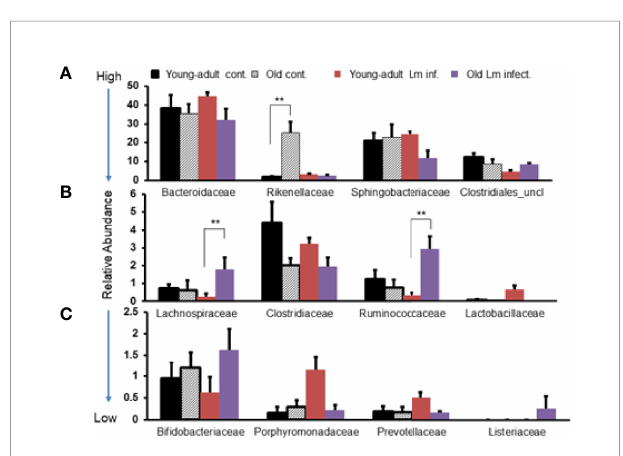
FIGURE 3 | Comparative representation of relative abundance of fecal microbiota at the family level in young-adult and old mice before and after Listeria monocytogenes infection. (A) Showing high abundance bacteria (>10%) at the family level. (B) Intermediate abundance level (<6%) bacteria at the family level. (C) Low level (<2%) bacteria at the family level. Taxonomic composition for the abundant bacteria at the family level was generated from k-mer analyses based on taxonomic pro fi ling. Data from mean ± SEM from a representative experiment using 4 – 6 mice. **p <